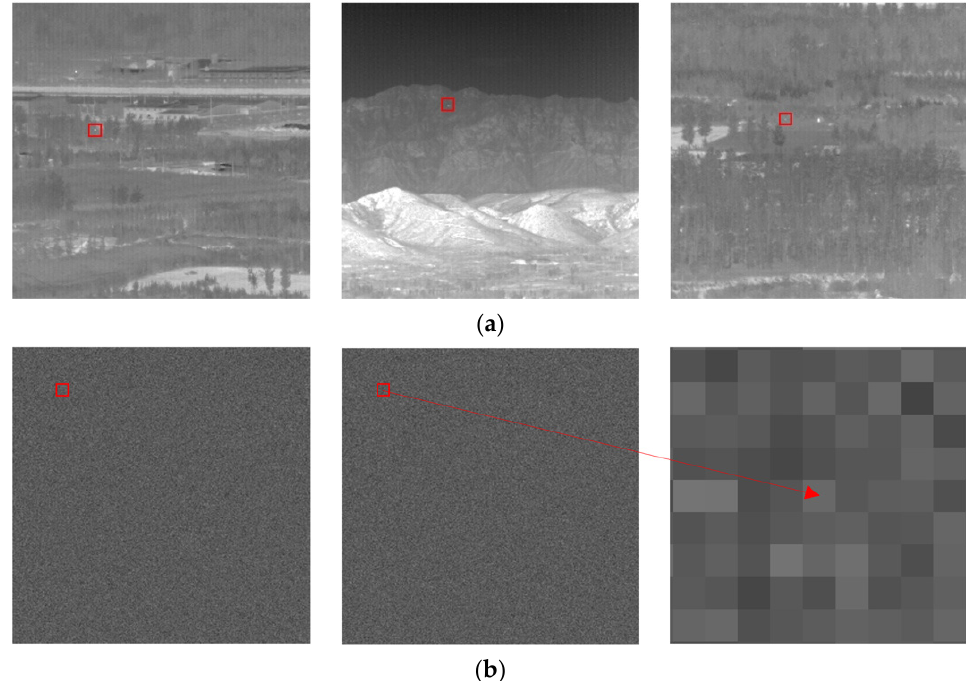
Figure 1. Representative infrared images with various backgrounds. ( a ) Background clutter is spatially nonstationary but temporally stationary; ( b ) Background clutter is temporally nonstationary, the area in red frame is the target and its neighbor pixels.